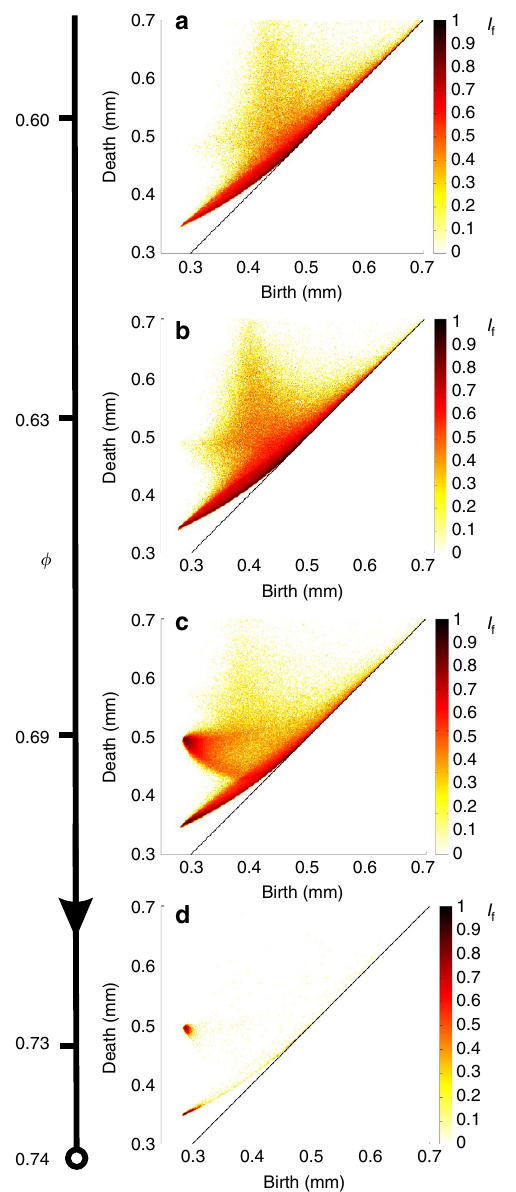
Figure 4 | PD 2 of disordered, partially ordered and highly ordered sphere packings. Representative PD 2 of sphere packings with density ranging from f ¼ 0.60 to f ¼ 0.73. Crystallization onset occurs at f E 0.64. The diagrams in panels ( a , b ) have been computed over more than 150,000 beads and 500,000 cavities. The diagram in ( c ) has been computed over more than 200,000 beads and 800,000 cavities. The diagram in ( d ) has been computed over more than 4,000 beads and 20,000